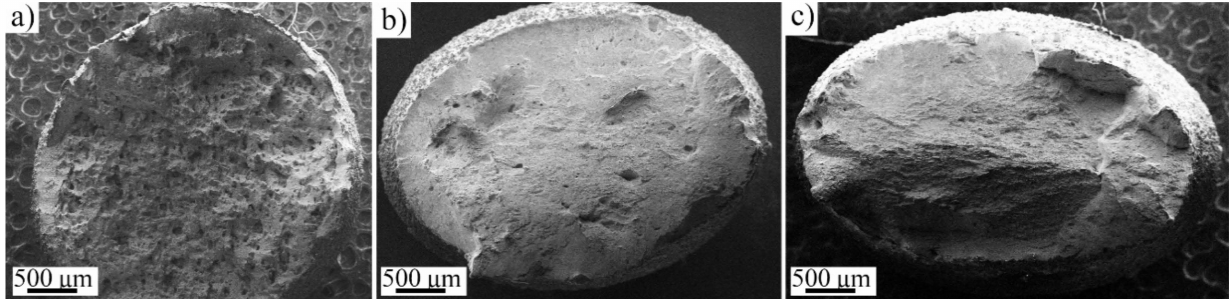
Figure 9. Macroscopic SE-images of ( a ) low-; ( b ) medium- and ( c ) high-VED samples strained at the lower strain rate.